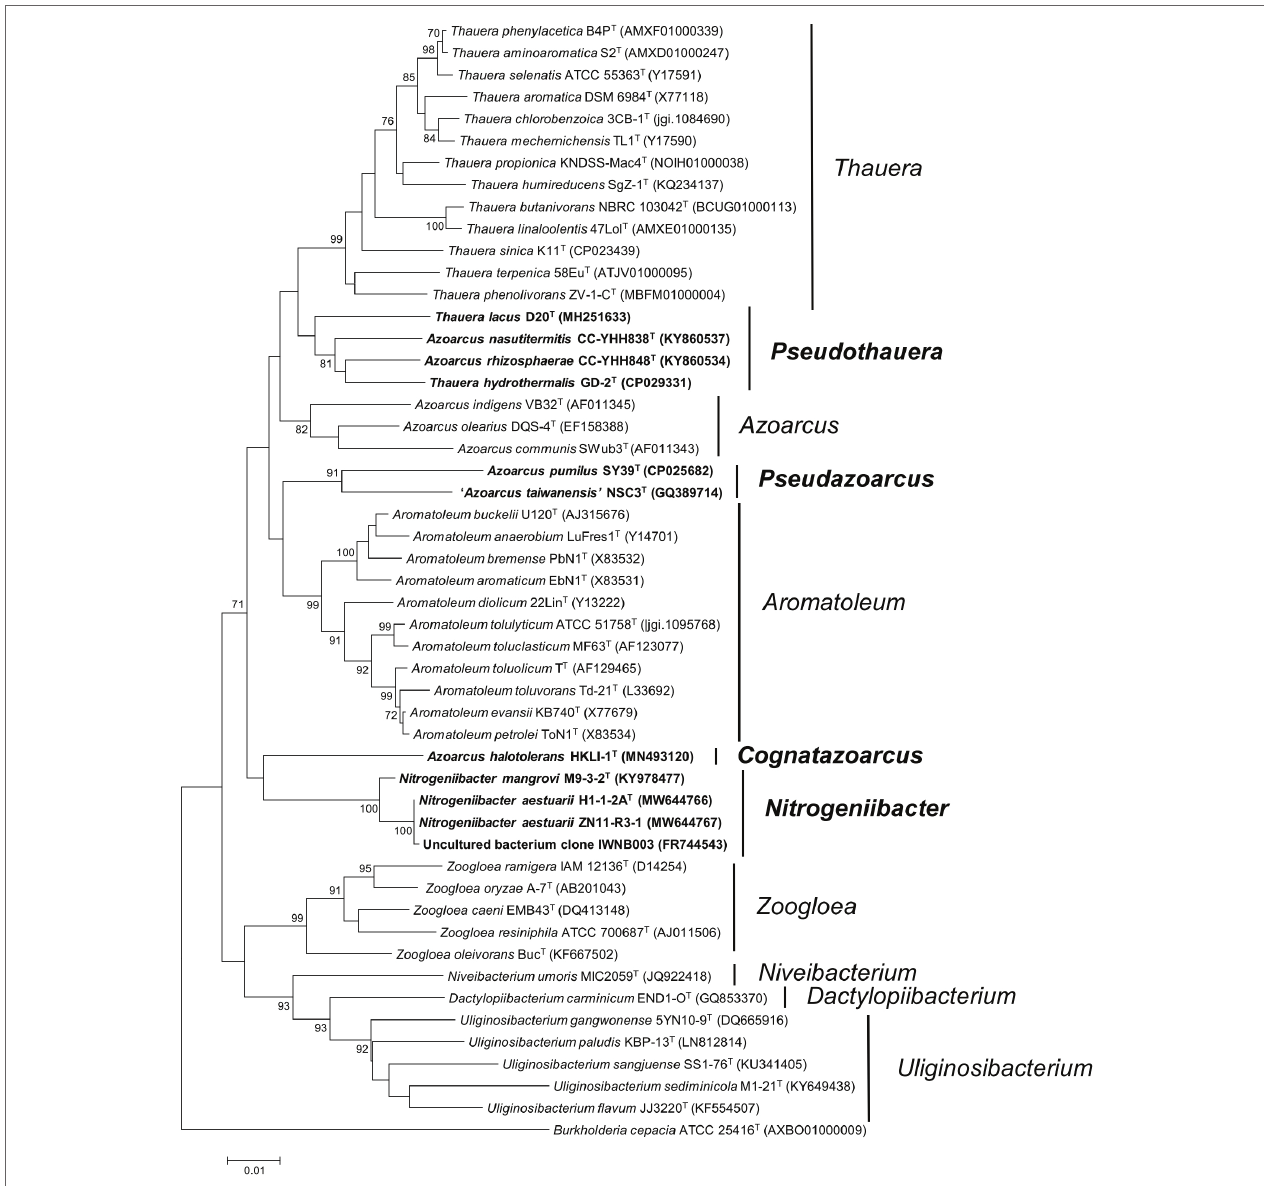
FIGURE 1 | Phylogeny of 16S rRNA gene sequences. The tree was constructed using the neighbor-joining method. Bootstrapping was carried out with 1,000 replicates. Branch node values below 70% are not shown. Burkholderia cepacia ATCC 25416 T (AXBO01000009) was selected as the outgroup. Bar, 0.01 represented the nucleotide substitution per position. Members of Nitrogeniibacter , Pseudazoarcus , and Pseudothauera are marked